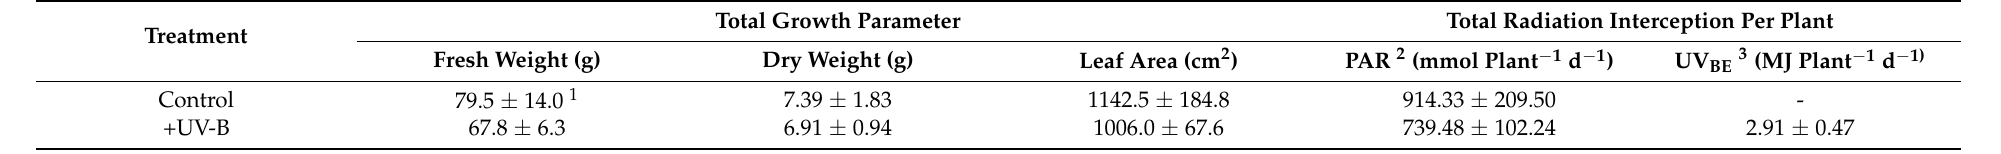
Table 3. Total growth and radiation interception of kales grown under the control and UV-B exposure conditions for 2 days before harvest.